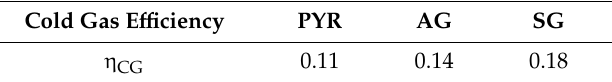
Table 4. Cold gas efficiency. Table 4. Cold gas e ffi